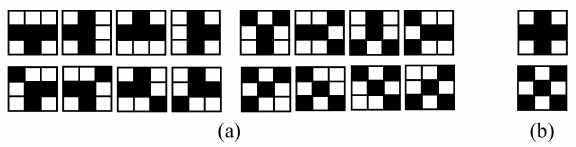
Figure 10. Masks used for the detection of ( a ) T-junction and ( b ) X- junction.